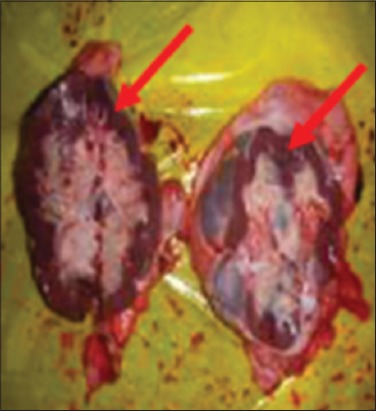
Congested and hemorrhagic kidneys.